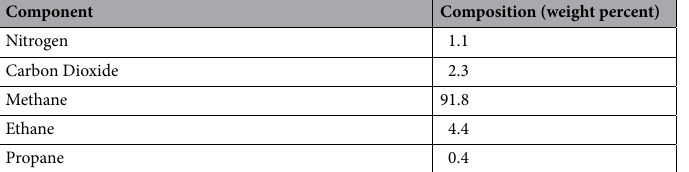
Table 2. Composition of hydrocarbon gas used for charging the shale samples. The estimated critical point of the multicomponent gas is 1070 psi and 31 °C using Peng Robinson equation of state. Hence, the hydrocarbon phase is supercritical at reservoir conditions and vapor at room conditions.